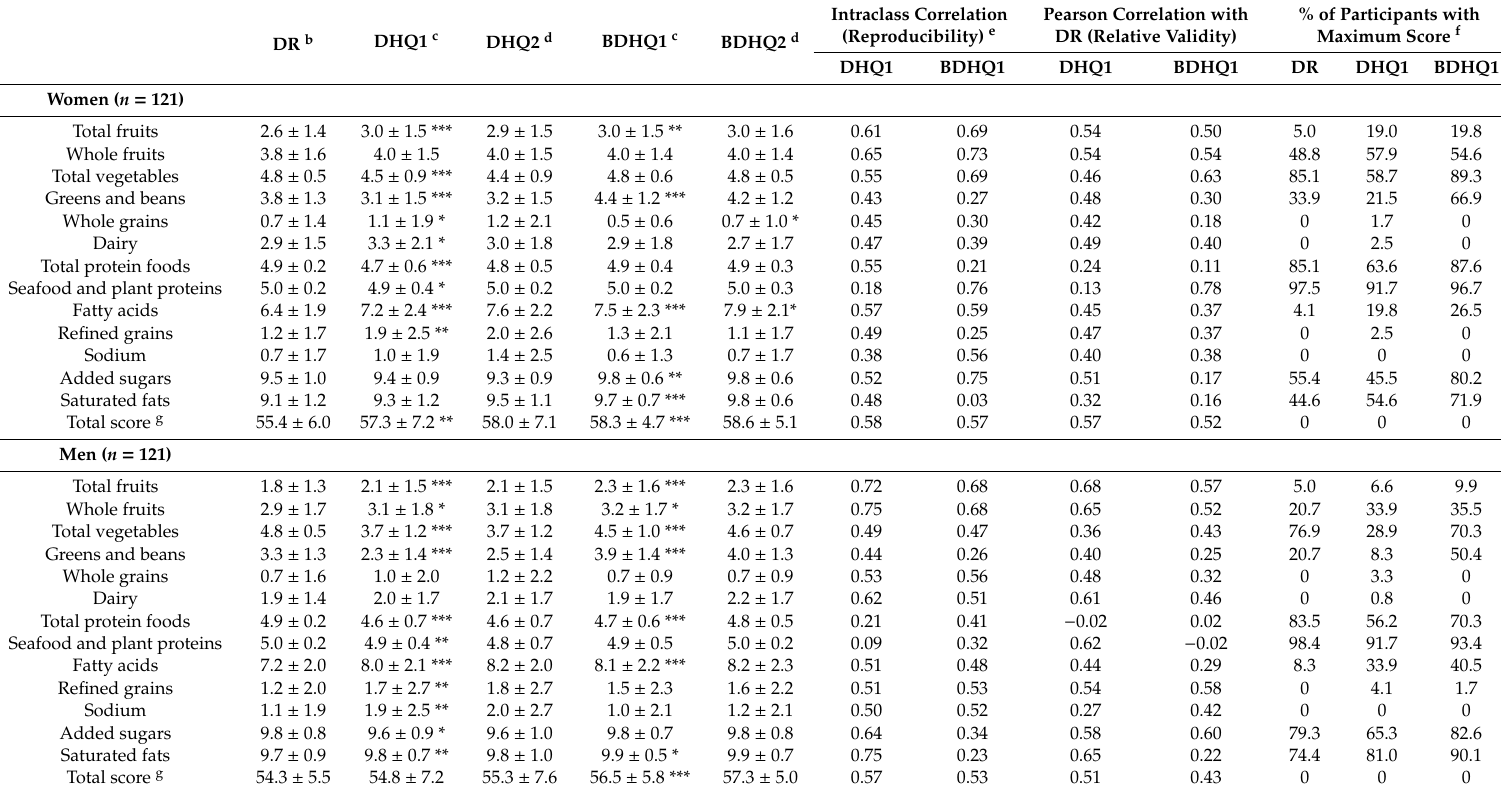
Table 2. Component and total scores of the Healthy Eating Index-2015 estimated from a 16-day weighed dietary record (DR) conducted over a year and a comprehensive diet history questionnaire (DHQ) and a brief diet history questionnaire (BDHQ) completed before and after the period of DR in Japanese women and men a